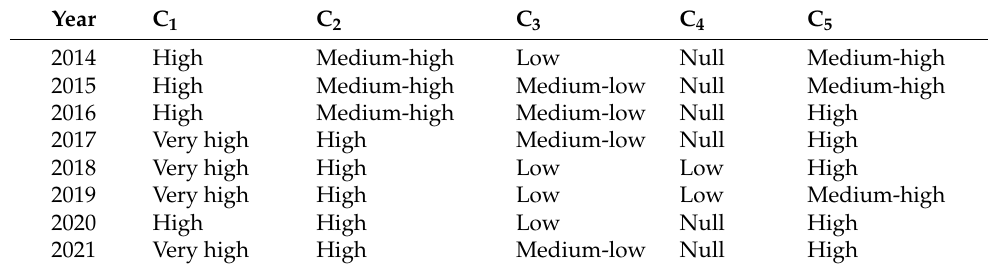
Table 6. Municipality 1 category relevancies measured annually from 2014 to 2021.